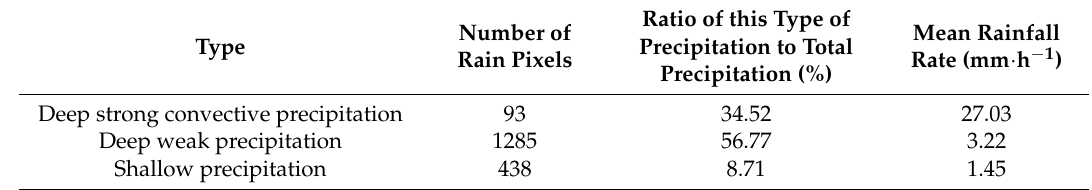
Table 1. Pixel number, percentage of total precipitation and mean rainfall rate of the three types of rain.